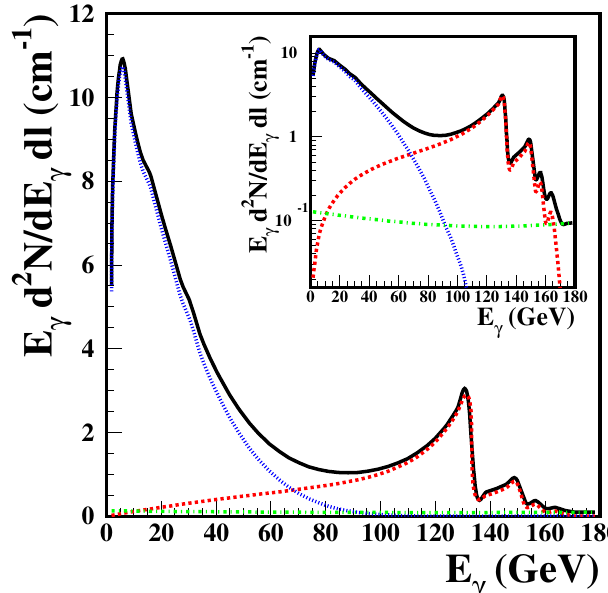
d 2 N=dE dl , per unit of (cid:1) (cid:1)